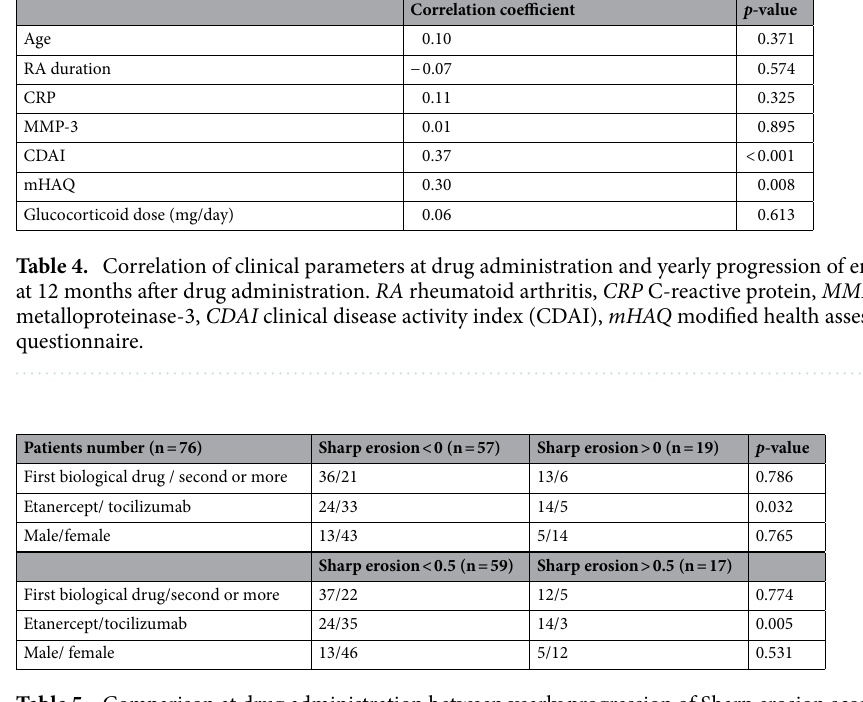
Table 5. Comparison at drug administration between yearly progression of Sharp erosion score ≦ 0, 0.5 group and > 0, 0.5 group.